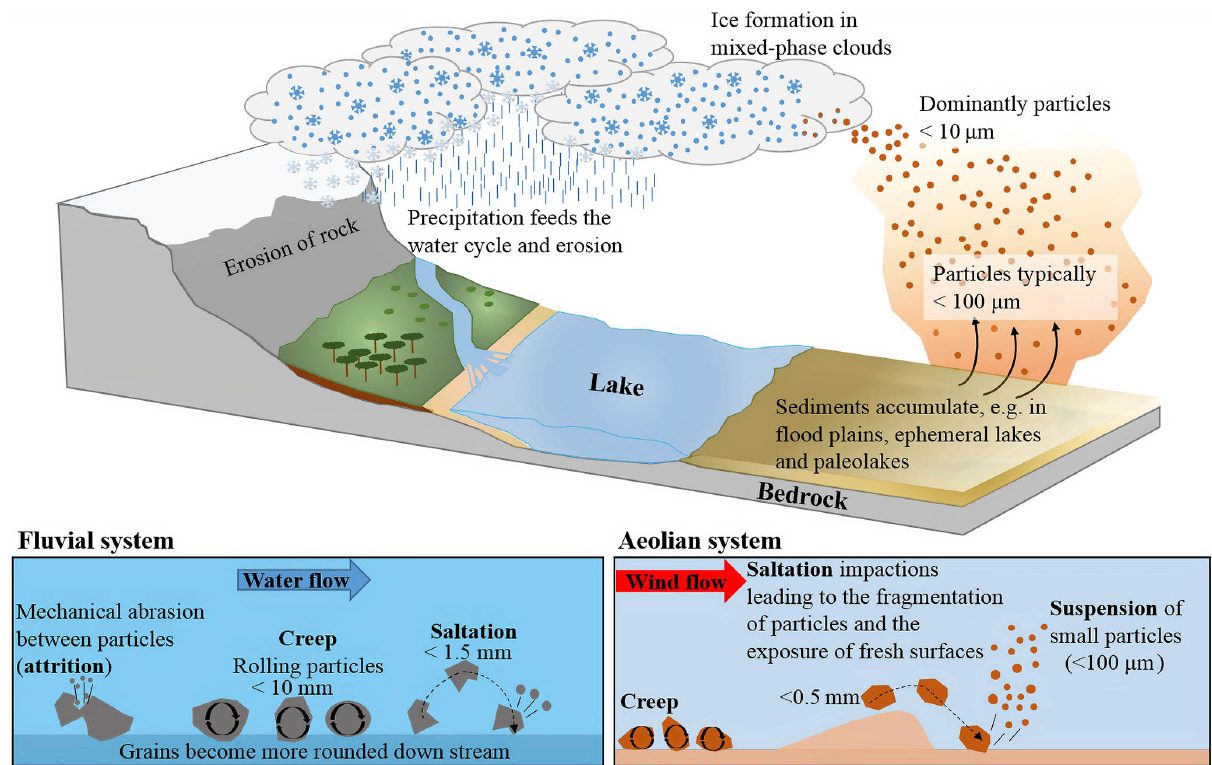
Figure 1. Illustration of the geological processes that lead to the creation of a mineral dust and its emission to the atmosphere. Saltation and creep occur both in fluvial and aeolian systems and are processes responsible for the movement of material. There is typically more energy in a fluvial system, and hence the particle sizes moved in these systems are larger. Attrition between particles causes them to fragment and to become more rounded on transport, with small particles becoming suspended in water or air. The particles smaller than ∼ 10µm in air can be transported for long distances and may interact with clouds, serving as INP, many hundreds or thousands of kilometres away from the source